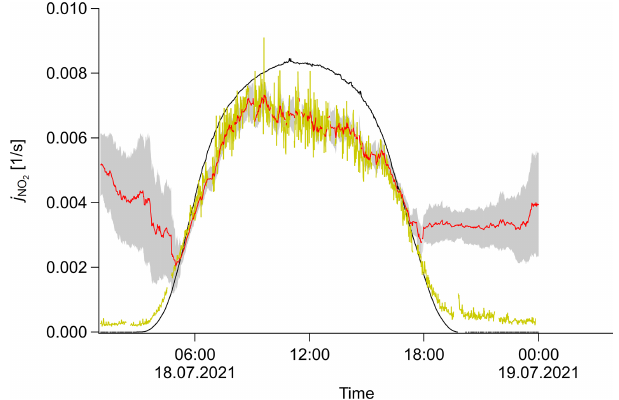
Figure 6. Example result of SMC method used for inference. Pho- tolysis frequency j as a function of time (UTC) for an arbitrary day of the field campaign. Original measurement (black), PSS calcula- tion (yellow), SMC ensemble mean (red) and ± 1 σ interval (shaded grey region).